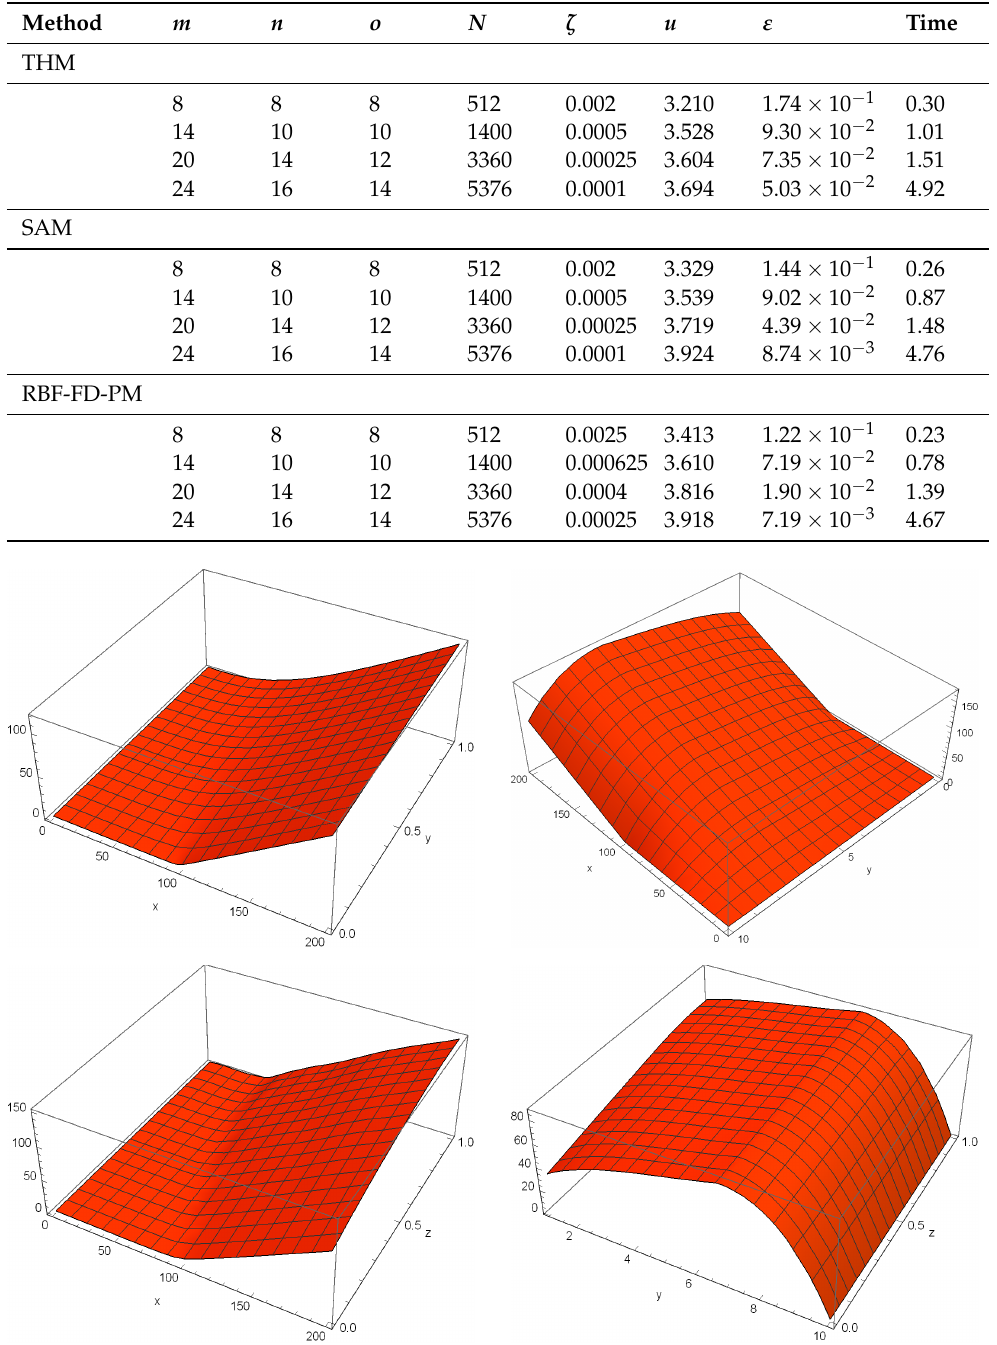
Figure 3. Numerical solution of the HCIR PDE in Case II. Top-left: for u ( x , y ,0.024,1 ) on 0 ≤ x ≤ 200, 0 ≤ y ≤ 1, Top-right: for u ( x , y ,0.024,1 ) on 0 ≤ x ≤ 200, 0 ≤ y ≤ 10, Bottom-left: for u ( x ,0.04, z ,1 ) on 0 ≤ x ≤ 200, 0 ≤ z ≤ 1 and Bottom-right: for u ( 100, y , z ,1 ) on 1 ≤ y ≤ 10, 0 ≤ z ≤